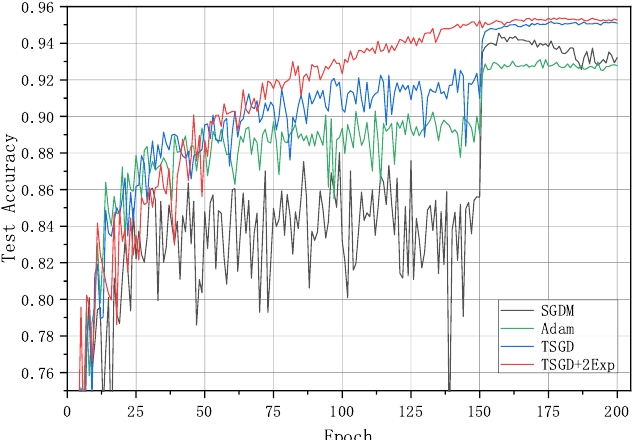
Figure 8. The accuracy of Cifar10-ResNet18 on the training set.